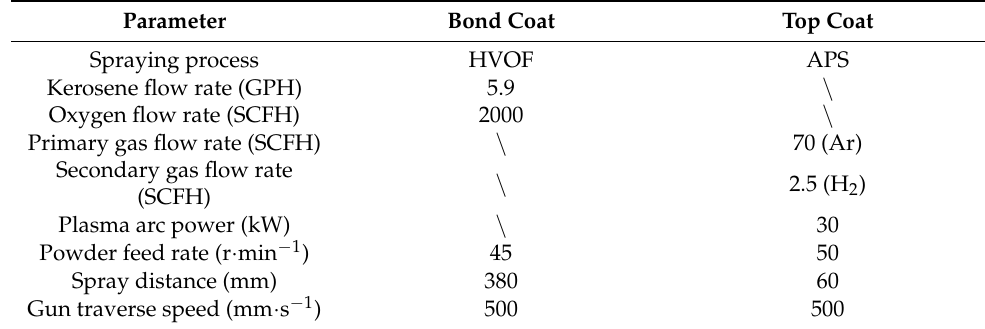
Figure 2. Image of TBC on a comb-shaped substrate. Table 1. Spraying parameters for top and bond coatings.